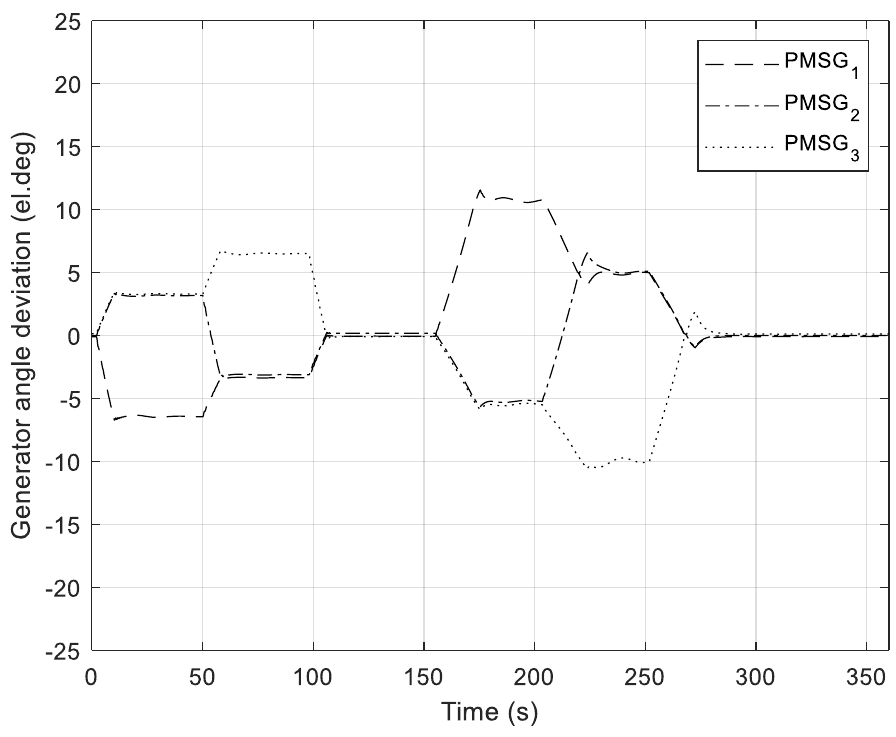
Figure 17. Deviations of rotor angles of PMSGs.